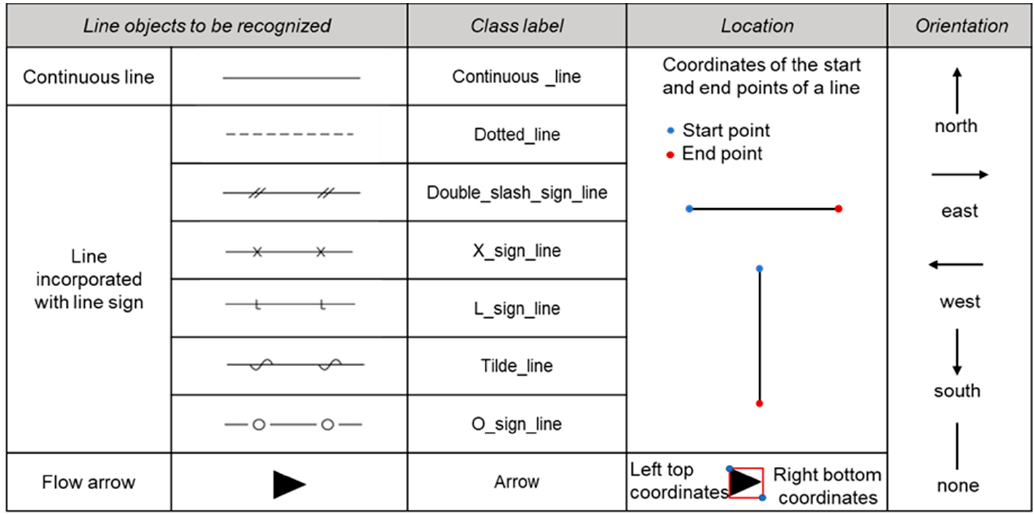
Figure 1. Definition of line objects to be recognized in P&IDs.